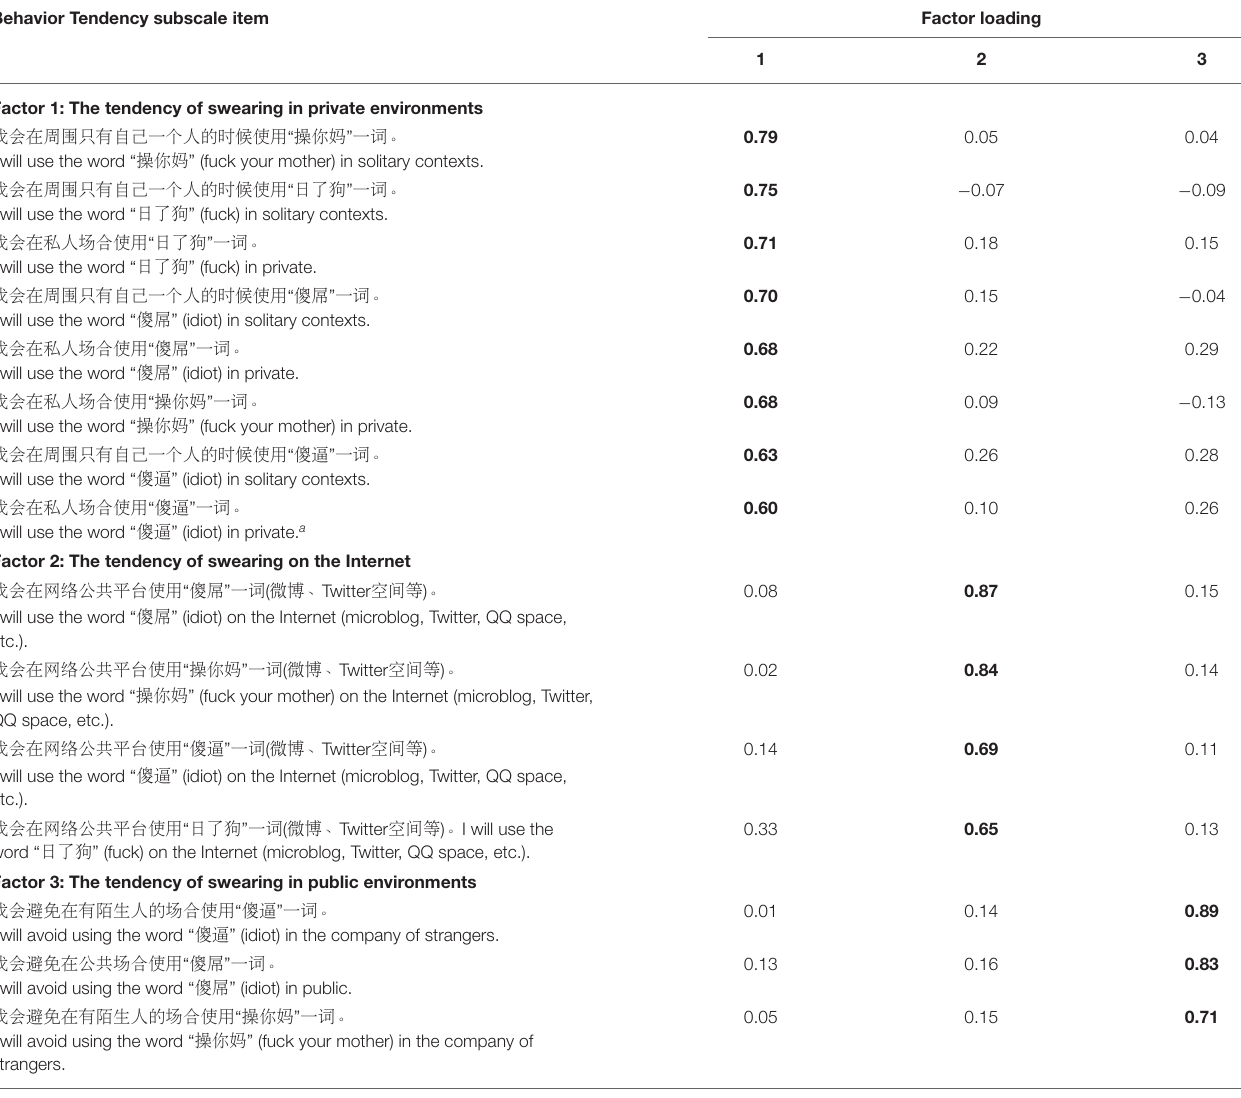
TABLE 4 | Exploratory factor analysis results of Behavior Tendency subscale. Behavior Tendency subscale